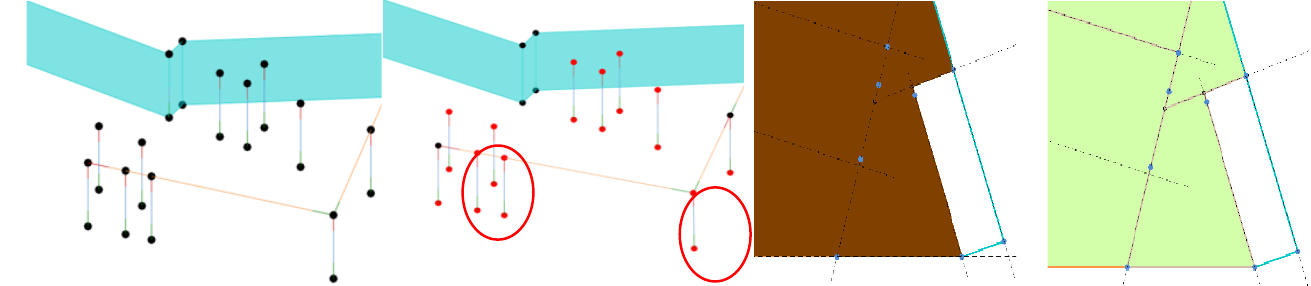
Figure 5. Visualization of the analytical model before and after applying the detect filter and the analytical model of a slab.